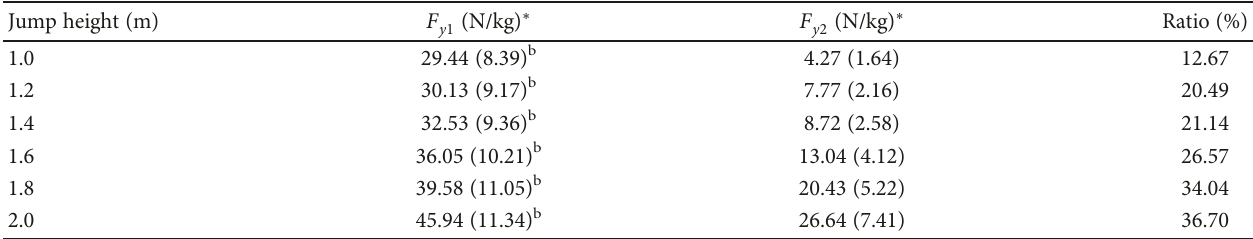
Table 1: Mean and SD of peak VGRFs and ratio of F